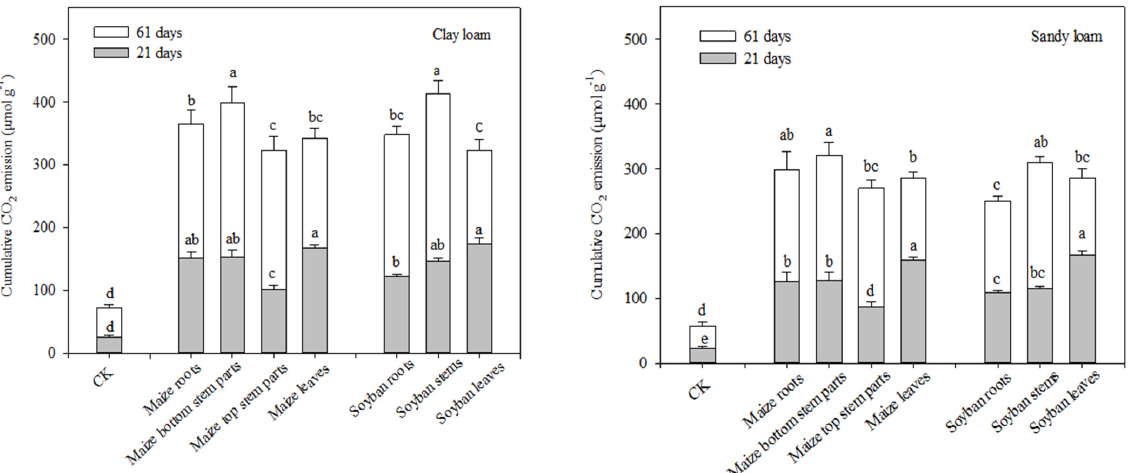
Figure 2. The cumulative CO 2 emission from soils amended with different residue types after 21 and 61 days of incubation. Vertical bars are the standard errors ( n = 4). Different lowercase letters indicate significant differences among residue types for a given incubation period at p ≤ 0.05. The data of CO 2 emission from soils amended with the seven residue types well fitted tk s ⋅− tk a ⋅− ) + C s · (1 − e )) ( R 2 > 0.99) the two-pool first-order decay model (C t = C a · (1 − e (Table 3). Except for the soils amended with maize top stem parts, the active C pools (C a ) were higher than the slow C pools (C s ) in soils with the other six residue types. The C a and the mineralization rate constants ( k a ) of active C of soils amended with all seven residue types were significantly lower in the clay loam than the sandy loam ( p ≤ 0.05). The C s was significantly greater in the clay loam than the sandy loam with a mineralization rate con- stant ( k s ) of slow C showing no distinguishable pattern. The active C had a significantly shorter half-life (T (1/2) a ) in the clay loam than the sandy loam while the half-life (T (1/2) s ) of slow C which was longer in the clay loam than the sandy loam ( p ≤ 0.05). For the clay loam, the C a in treatments with maize leaves (40 μ mol g − 1 soil) and soy- bean leaves (41 μ mol g − 1 soil) was notably higher than that with other residues, and the C a the treatment with maize top stem parts (16 μ mol g − 1 soil). The C a in various residue treat- ments showed a similar pattern in the two soils (Table 3). The variations in C a among the treatments were consistent with cumulative CO 2 emission in the early period (21 days) of incubation. Soils with maize top stem parts had the largest C s (40~57 μ mol g − 1 soil), fol- lowed by soils with soybean stems, whereas soils with leaves of maize and soybean had